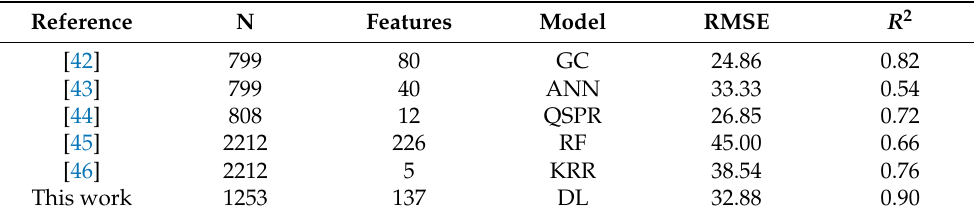
Table 1. The performance metrics for predictions of the ILs melting temperature obtained in this work compared with that of the literature. N refers to the size of the entire dataset, which is the total number of ILs. GC refers to group contribution; ANN is artificial neural network; QSPR is quantitative structure-property relationship; RF is random forest; KRR is kernel ridge regression. For the RMSE, the unit is in Kelvin